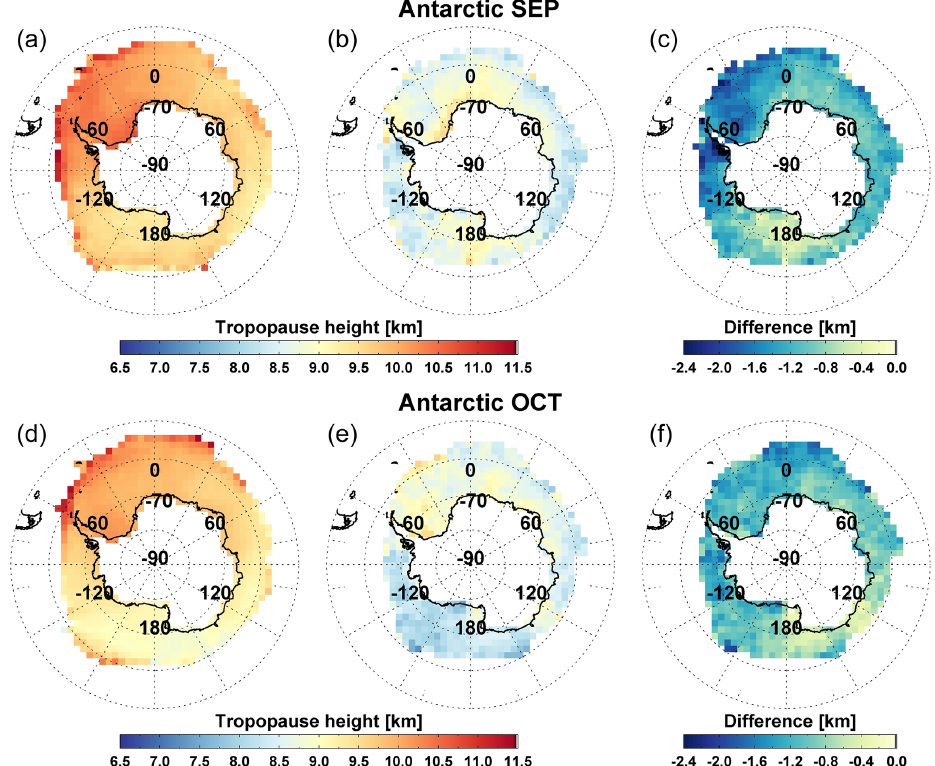
Figure 19. As Fig. 18 but for the Antarctic in September (a–c) and October (d–f)